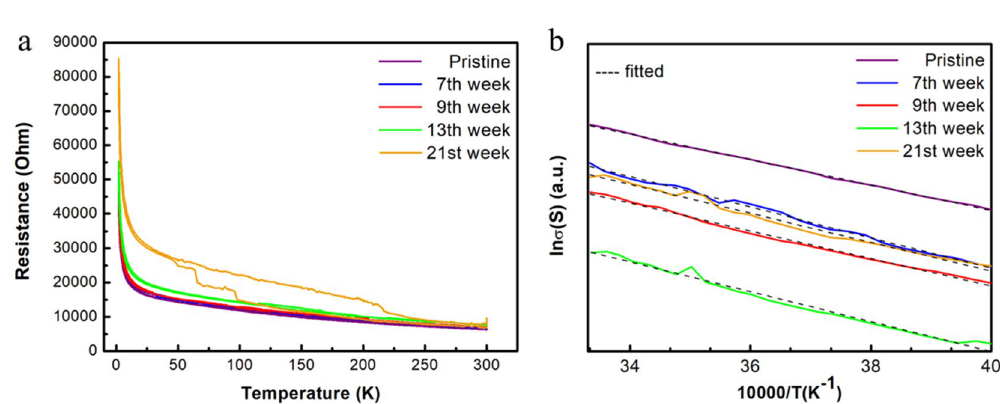
Figure 5. ( a ) Temperature dependence of the four terminal resistances in up to 21 weeks. ( b ) The barrier energy results in room temperature range for samples exposed different time in